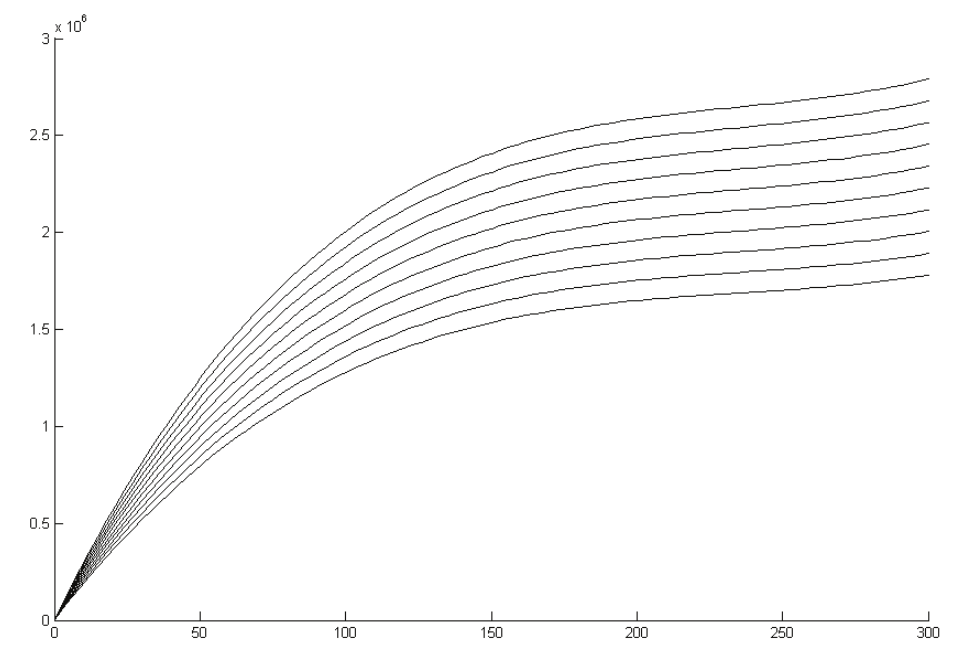
figure 10. The fitting curves when θ is changing between 45000 and 60000